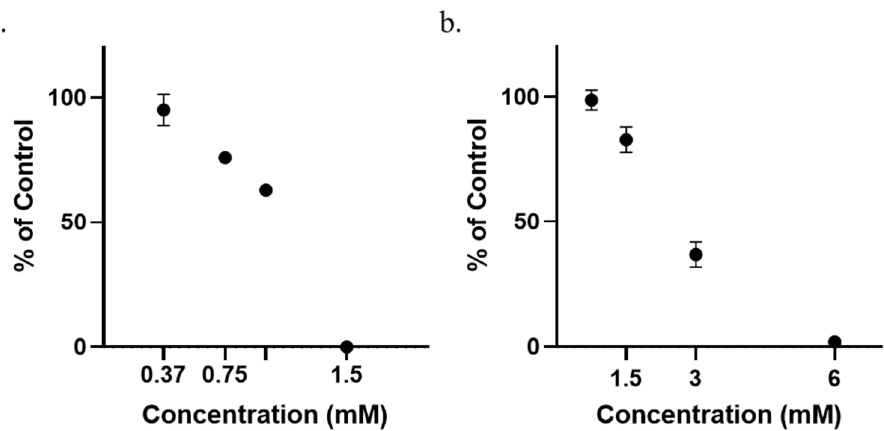
Figure 1. Minimum inhibitory concentrations (MIC) of ( a ) DSA [bis(2-carboxyphenyl) succinate] and (b) salicylic acid against Pectobacterium brasiliense Pb1692. The inoculum density was 1 × 10 6 mL − 1 CFU. Bacteria were exposed to 0.3–1.5 mM DSA or 1.5–12 mM SA and incubated for 18 h at 28 ◦ C. Final bacterial concentrations were assessed by measuring absorbance at 600 nm. Data points represent the averages of three independent experiments with 8 replicates each (bar = SE; n = 3).